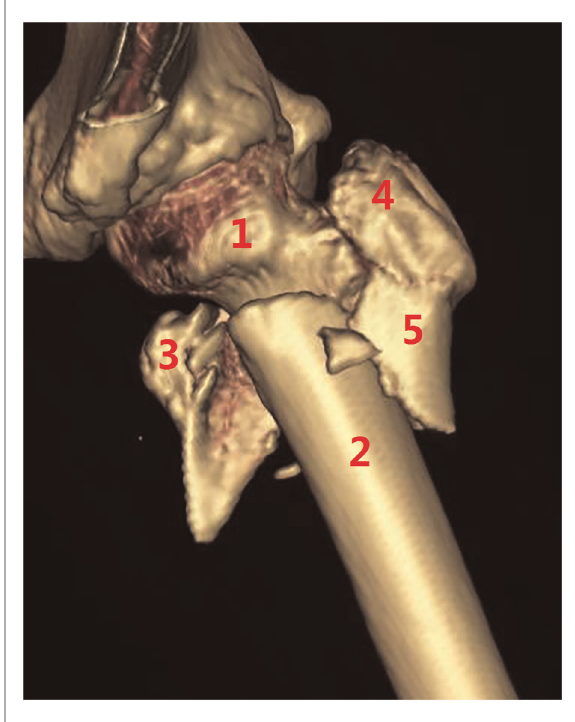
FIGURE 11 Subtype A3.4, a pantrochanteric fracture with fi ve fragments separated. (1) Head – neck fragment, (2) femoral shaft, (3) lesser trochanter, (4) greater trochanter, and (5) lateral wall.